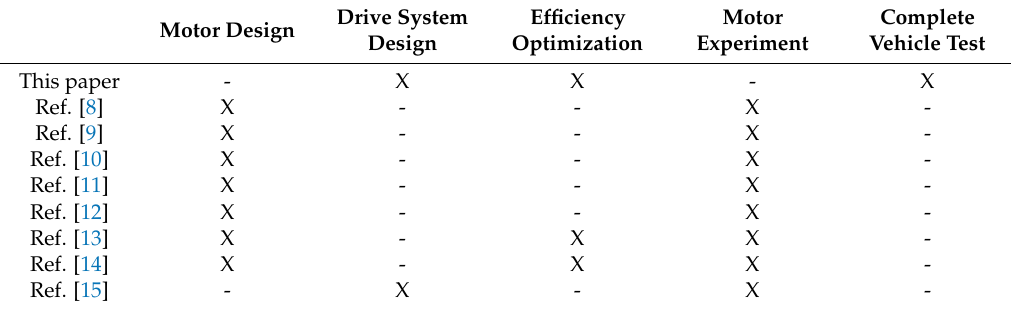
Table 1. List of the research contents covered by the